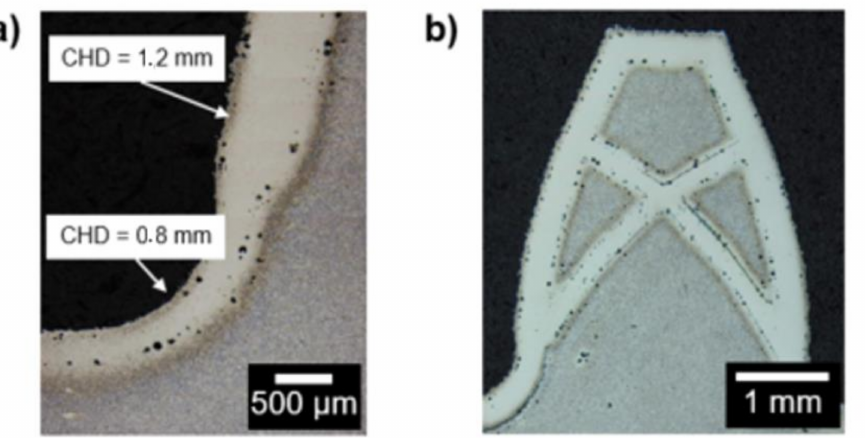
Figure 10. Potential of the combination of in situ alloying and multi-material processing ( a ) Tooth with various case hardening depths produced with multi-material PBF-LB/M ( b ) Tooth with inherent pressure-resistant zones of high strength